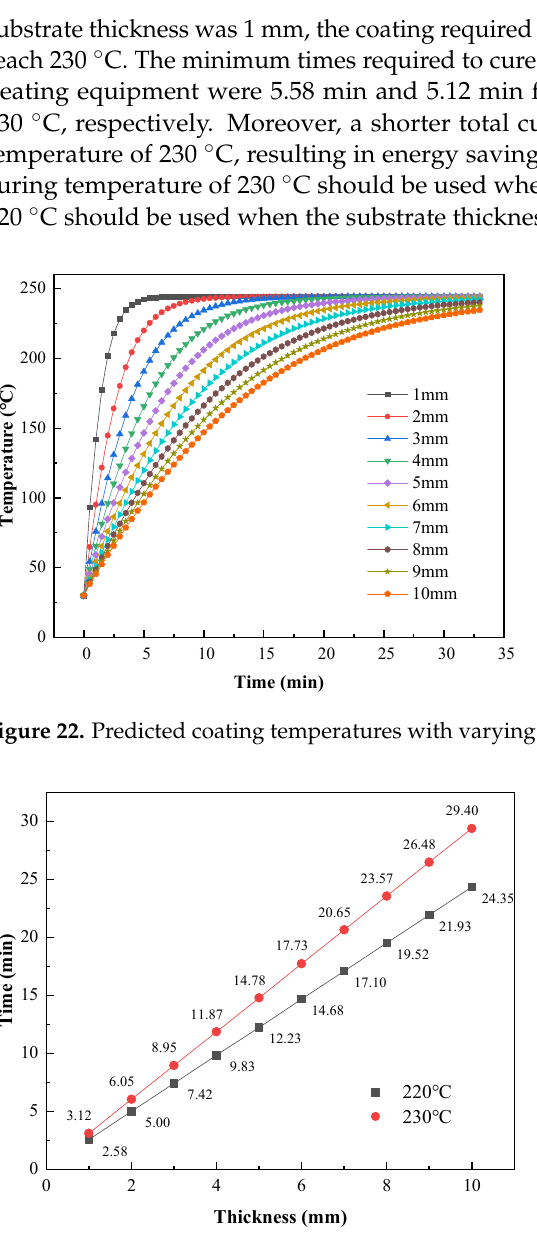
Figure 23. Heating times required for the coating temperature to reach 220 °C and 230 °C with different substrate thicknesses.